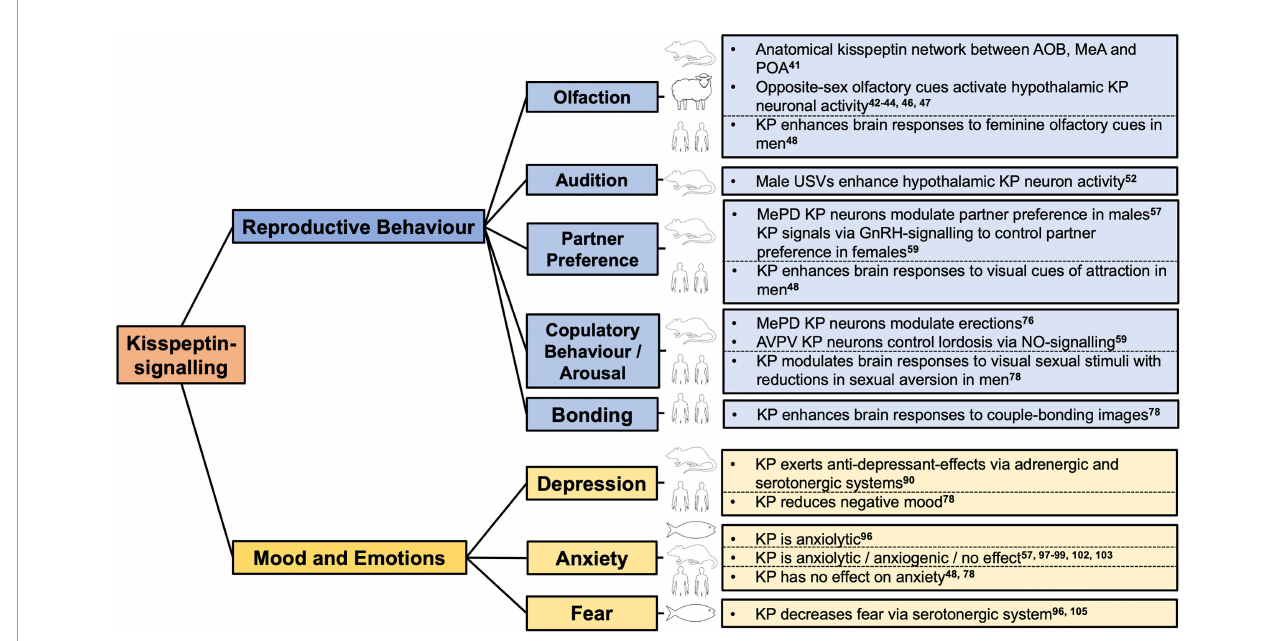
FIGURE 1 | Kisspeptin-signalling has neuromodulatory effects on reproductive behaviour, mood and emotions in zebra fi sh to humans. AOB, accessory olfactory bulb; AVPV, anteroventral periventricular nucleus; GnRH, gonadotropin releasing hormone; KP, kisspeptin; MeA, medial amygdala; MePD, posterodorsal subnucleus of the medial amygdala; POA, preoptic area; USVs, ultrasonic